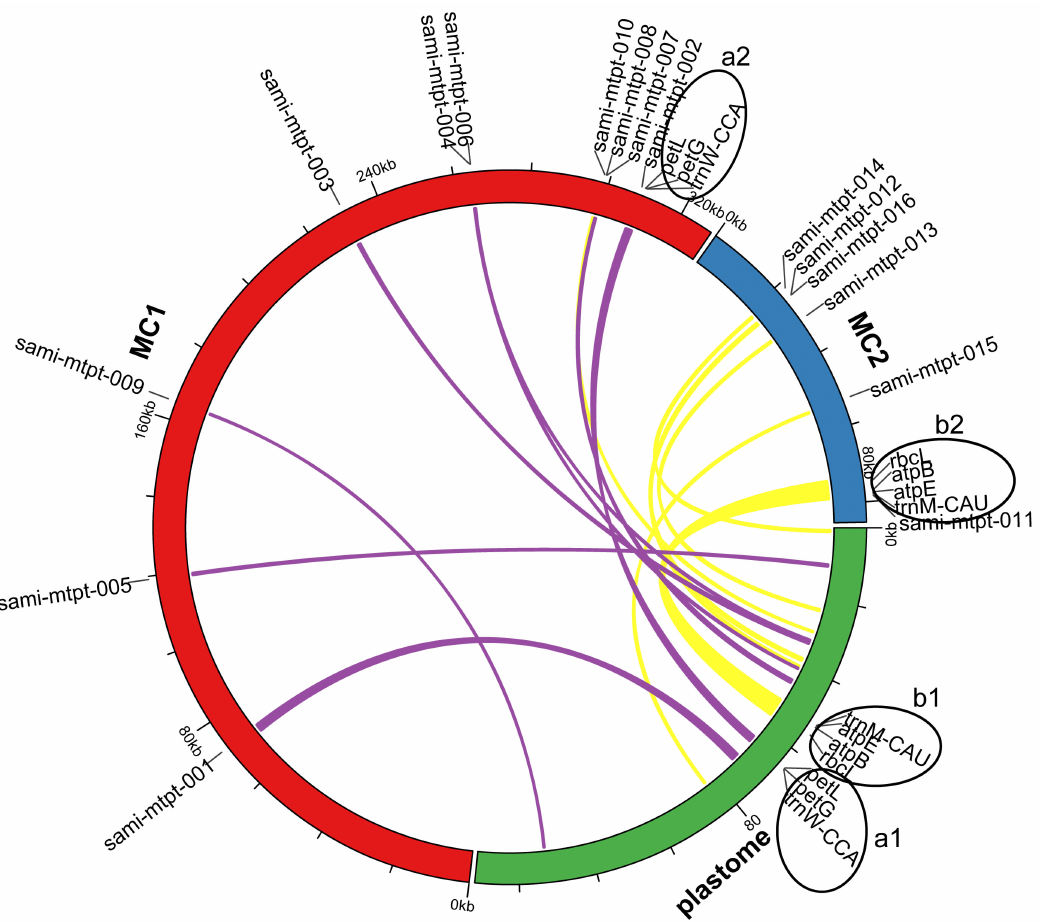
Figure 6. Circular map showing the distribution of MTPT on MC1 and MC2 of the S. miltiorrhiza mitogenome. The red and blue lines of the outer circle represent the MC1 and MC2 of the S. miltiorrhiza mitogenome, respectively. The green line of the outer circle is the plastome of S. miltiorrhiza . The purple and yellow links in the inner circle represent MTPT on MC1 and MC2 of the S. miltiorrhiza mitogenome, respectively. a1 and a2 denote the gene cluster of the MTPT fragment sami-mtpt-002 located on MC1 and plastome, respectively. b1 and b2 represent the gene cluster of the MTPT fragment of sami-mtpt-011 located on MC2 and plastome,